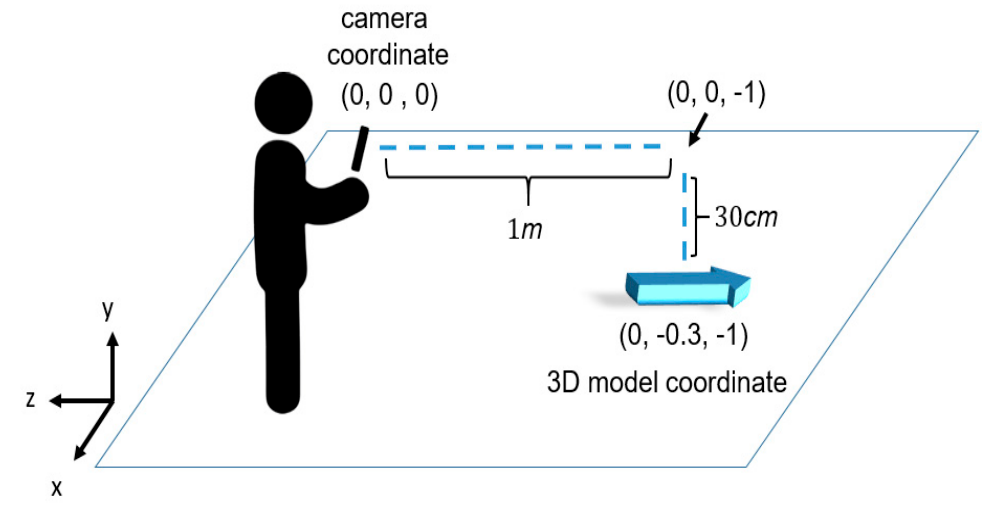
Figure 9. The coordinates of a 3D model.